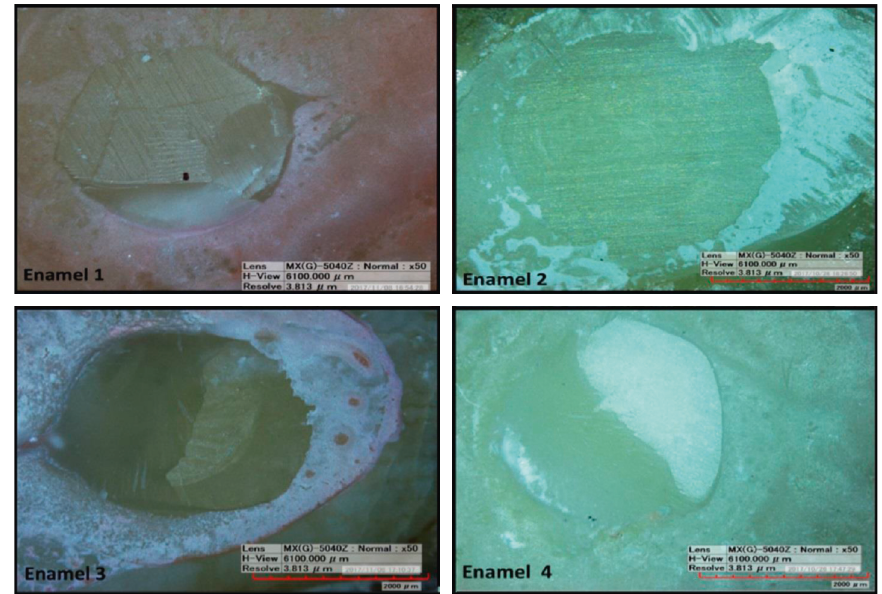
Figure 3: Digital microscopy images of bonded enamel specimens after the shear bond strength test.